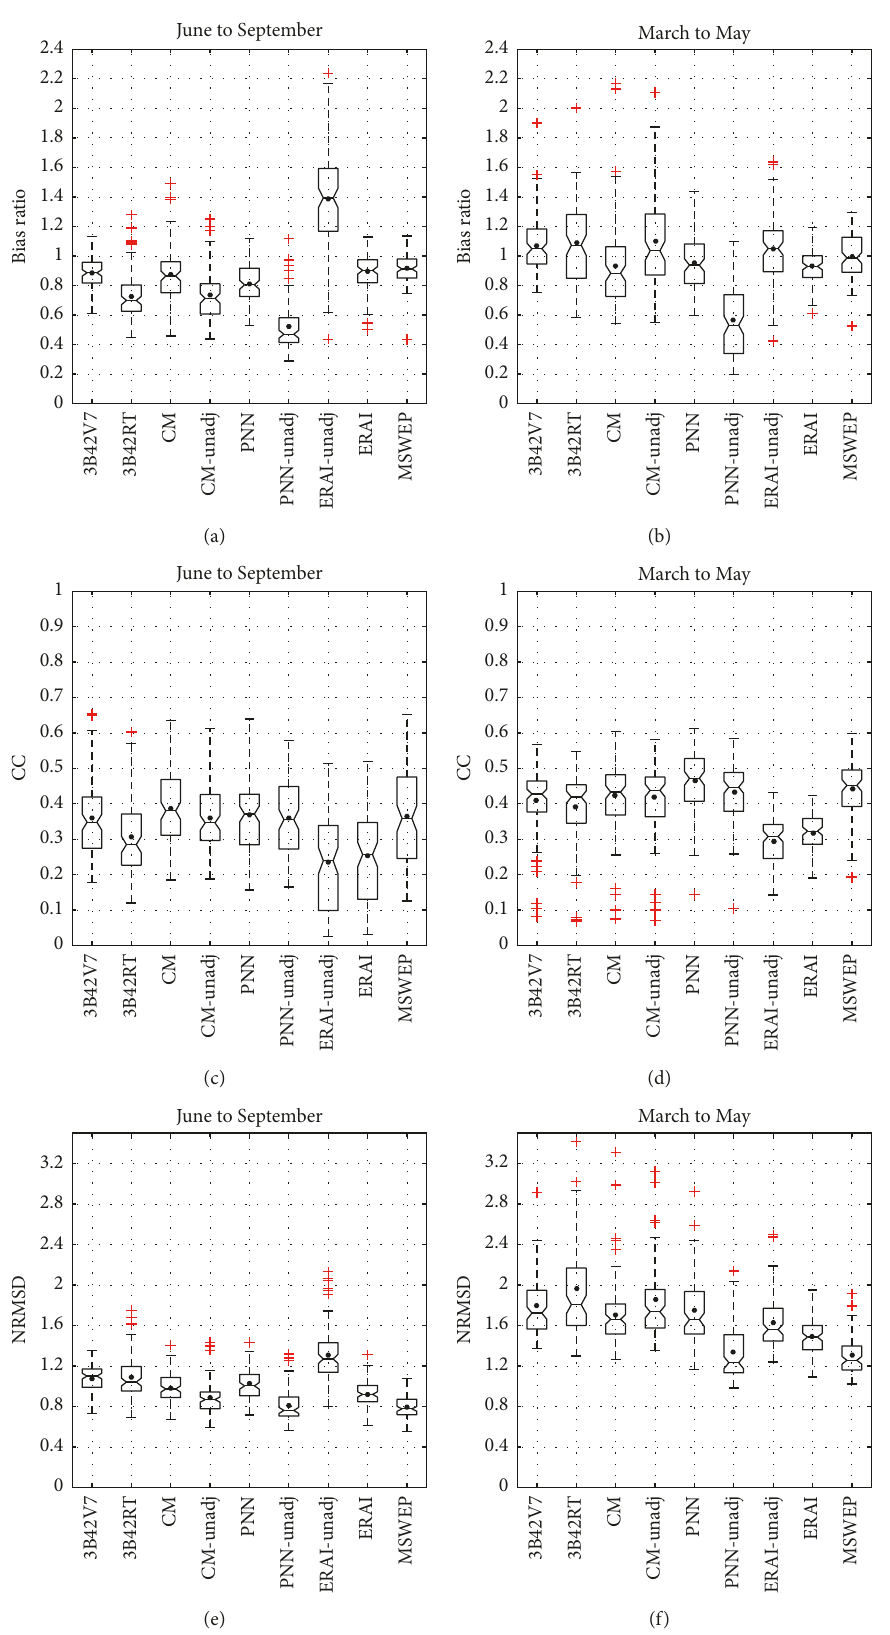
Figure 7: Statistical error metrics of bias ratio (a and b), CC (c and d), and NRMSE (e and f) for the rainfall